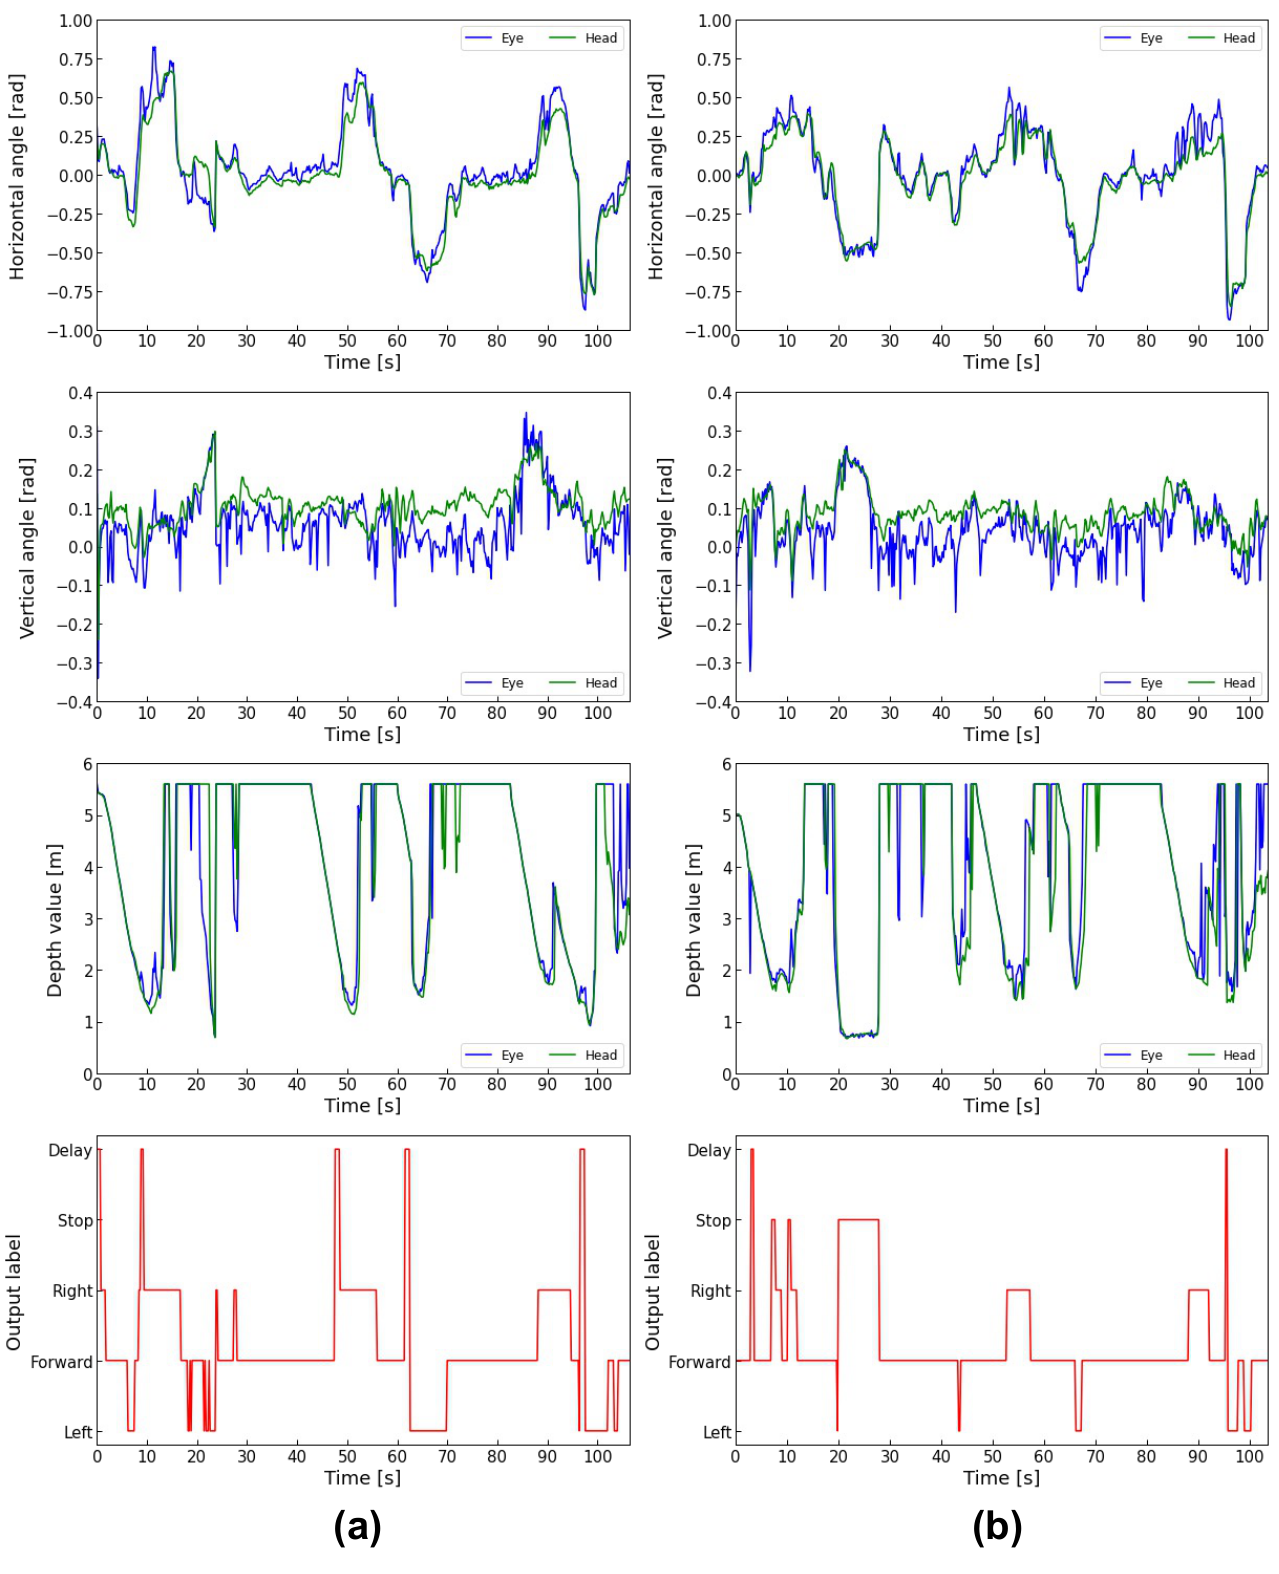
Figure 15. Comparison of Subject C’s driving data: ( a ) Driving data in the traditional method; ( b ) Driving data in the proposed